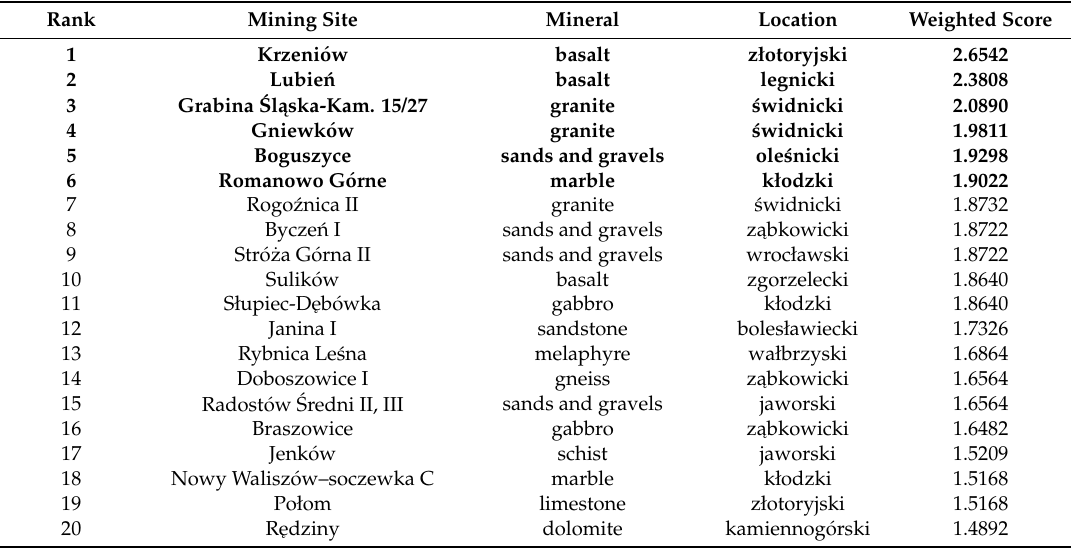
Table 4. Ranking of mining waste